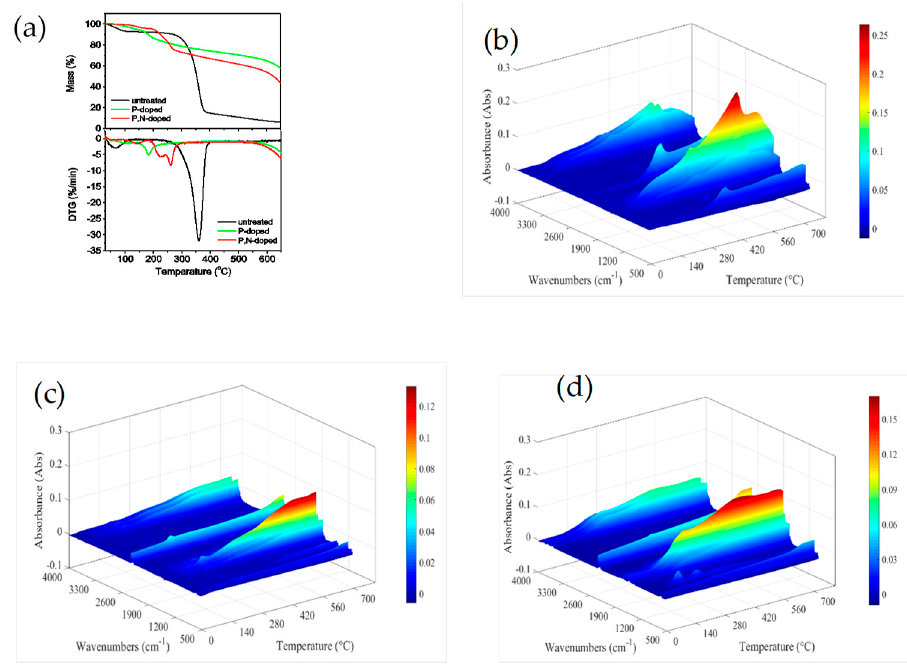
Figure 4. Thermal results of untreated and treated cellulose. ( a ) TG-DTG curves, and the three-dimensional infrared spectra of TG-FTIR of ( b ) untreated cellulose, ( c ) P-doped cellulose, and ( d ) P,N- doped cellulose fibrils.